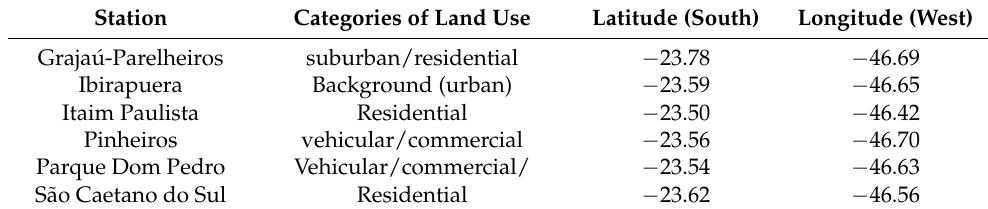
Table 1. Categories of land use defined by the WHO and in the location of AQMS.